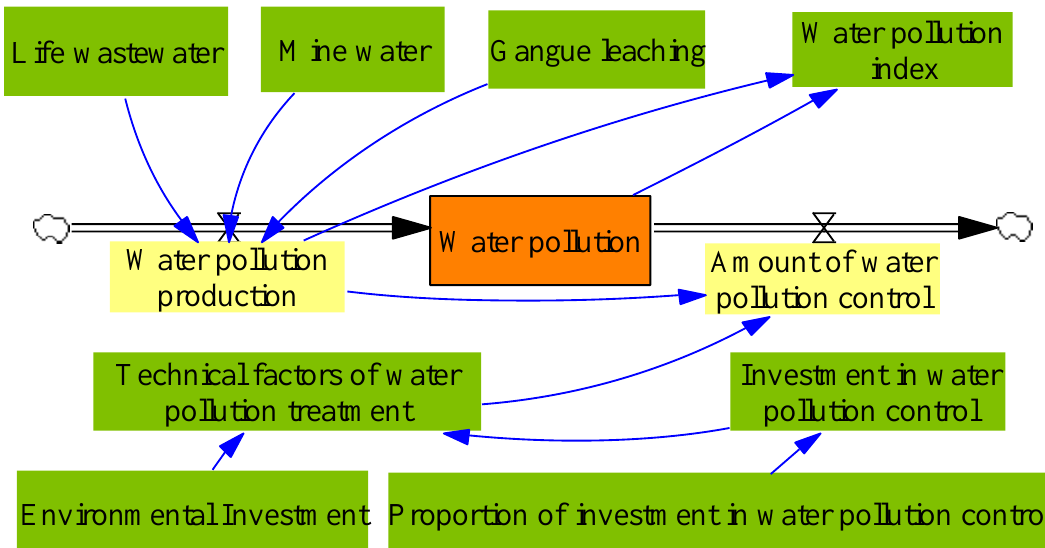
Figure 4. The system flow diagram of water resource subsystem.